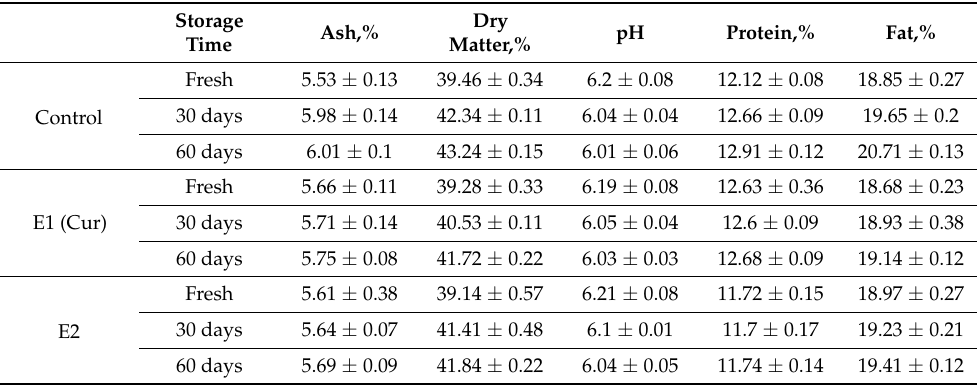
Table 3. Physicochemical analysis of cheese. Storage Time Ash,% Dry Matter,% pH Protein,% Fat,% Contro